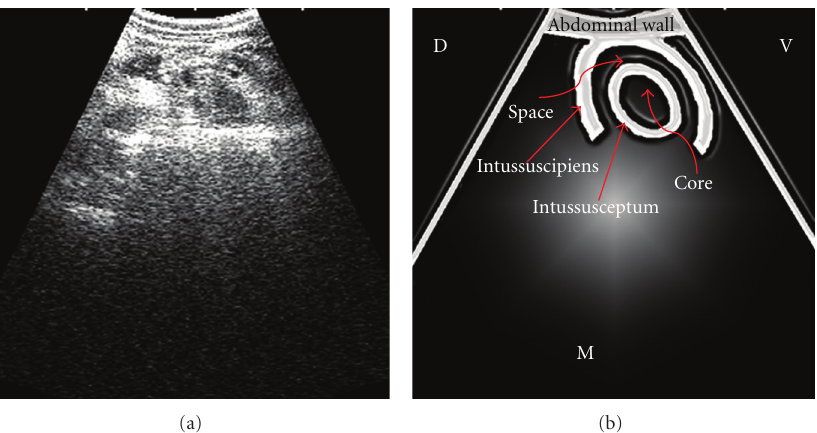
Figure 1: Ultrasonogram of jejunal intussusception imaged from ventral flank in cross-section. D: dorsal, V: ventral, M: medial.